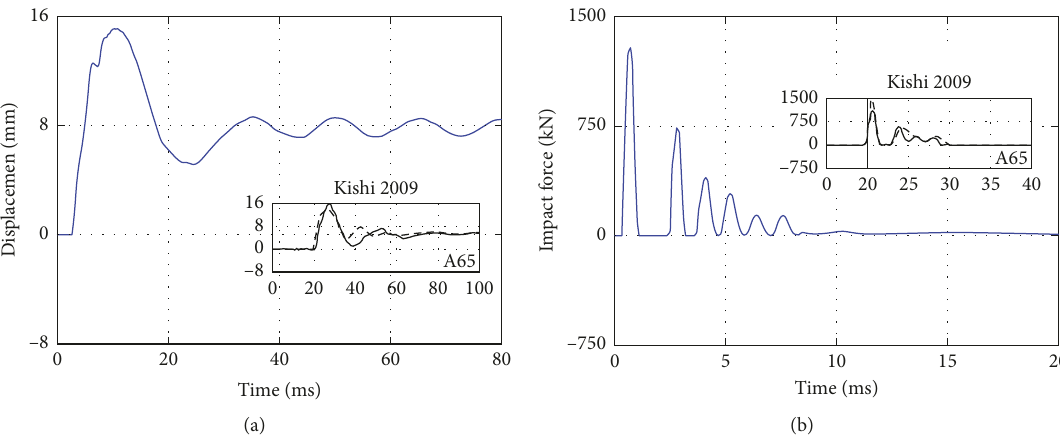
Figure 6: Impact response comparisons of RC beam at the speed 6.5m/s. (a) Time-history curve of midspan displacement. (b) Time-history curve of impact